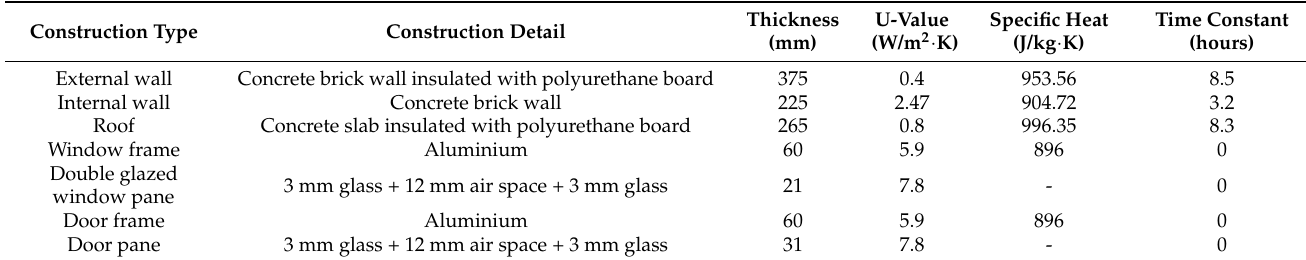
Table 3. Construction details of Hudhayfah mosque.